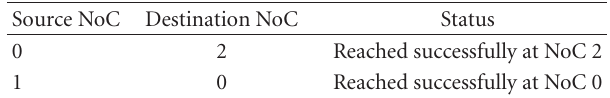
Table 10: The payload successfully reached to its desired destina- tion